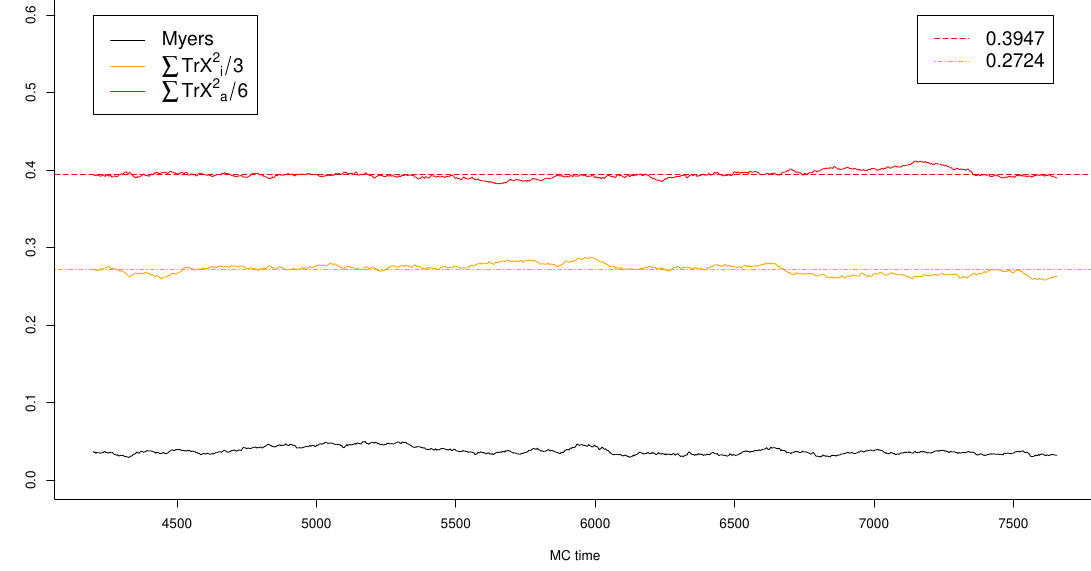
/ 3 and Tr X 2 / 6 grouped together show a i